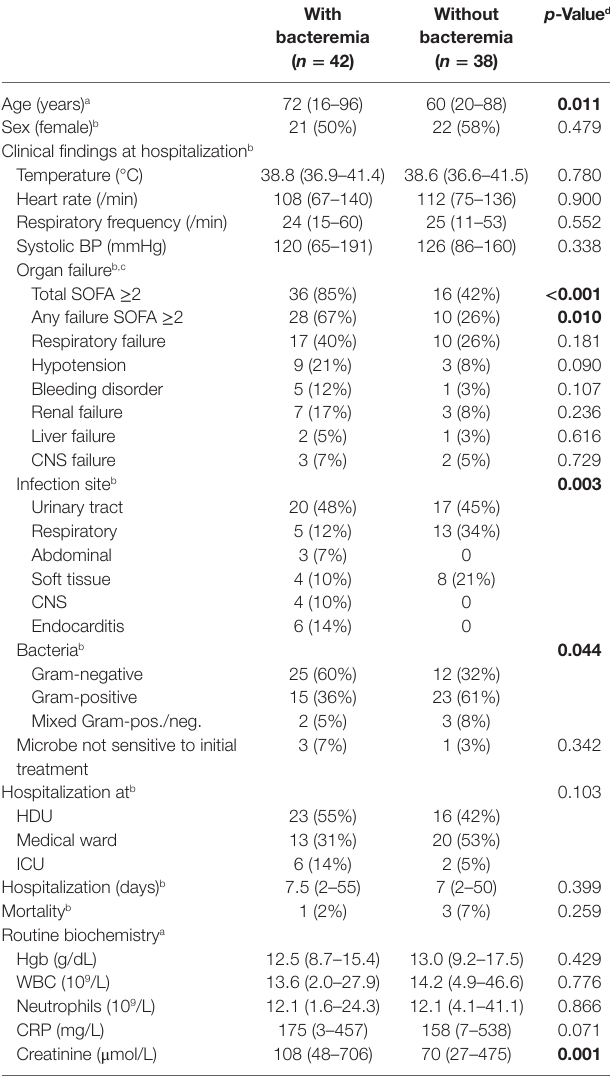
TaBle 1 | Clinical characteristics for patient groups with and without